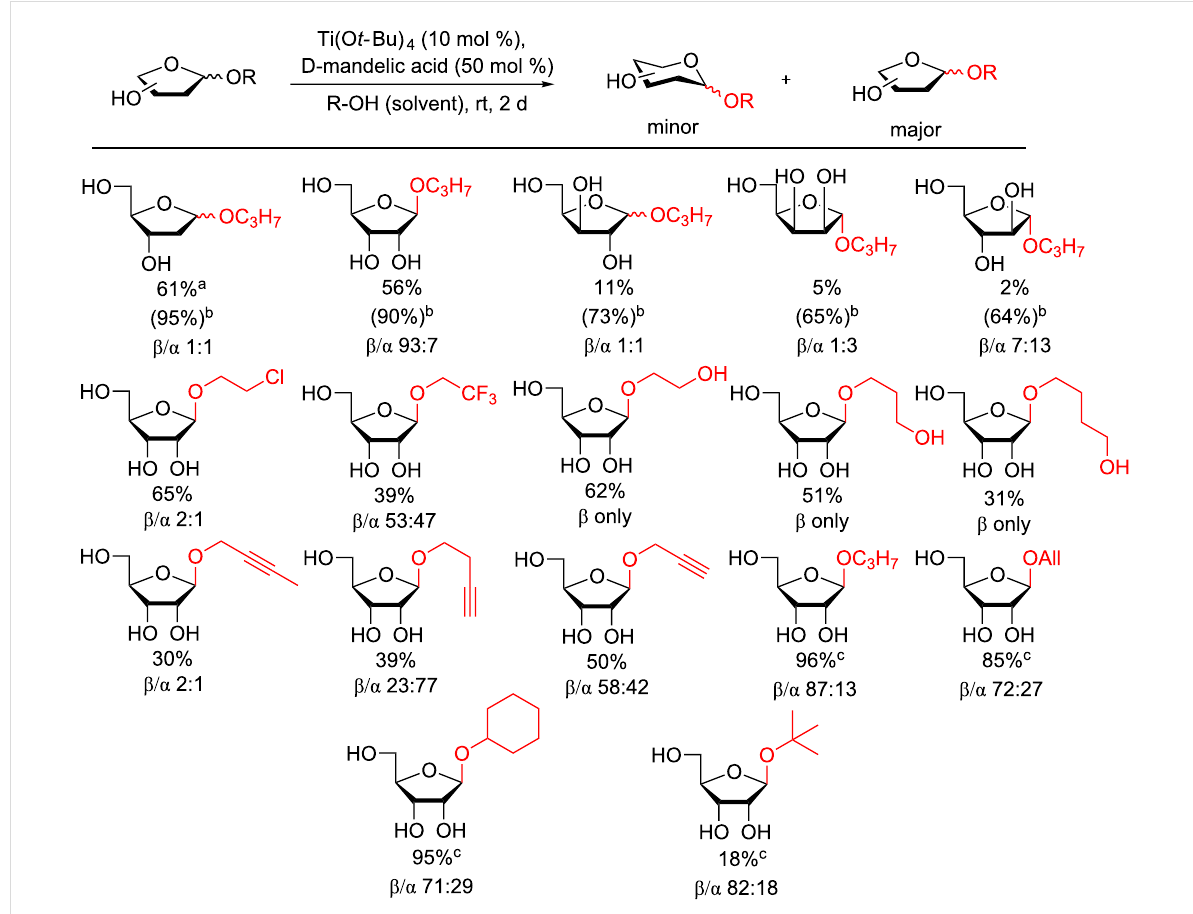
Figure 13: Direct glycosylation of several aliphatic alcohols using catalytic Ti(O t- Bu) 4 in the presence of D-mandelic acid. The furanoside is the major or exclusive product. a Only 4 mol % D-mandelic acid used. b After 12 days and 1.0 equiv LiBr added. c 1.0 equiv LiBr added to enhance the yield.